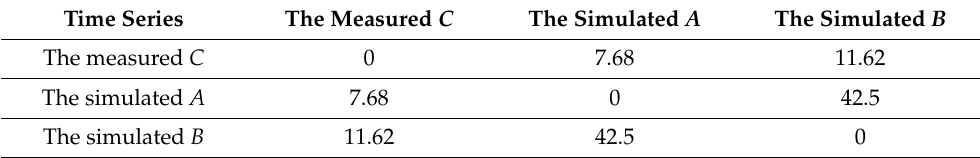
Table 6. Dynamic time warping distance calculation results (calculation period [0, 1000]).